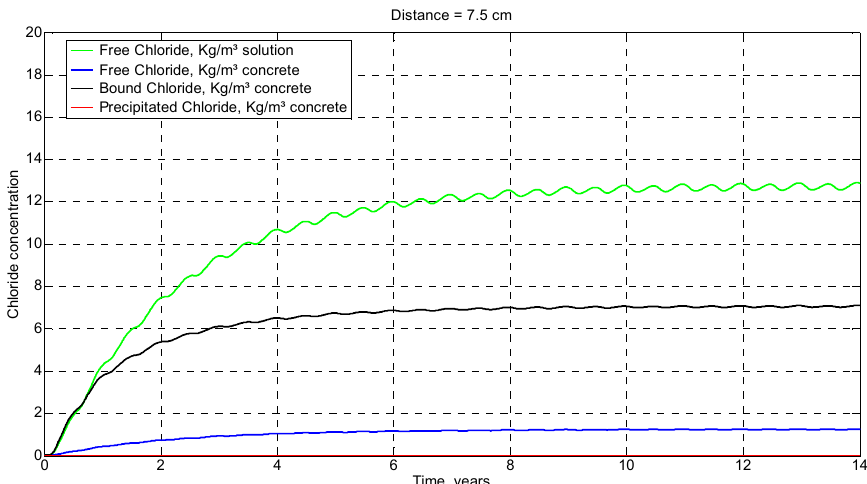
Figure 21. Time dependent concentration of C f,s (free chloride in kg/m 3 solution), C f,c (free chloride in kg/m 3 concrete), C b (bound chloride in kg/m 3 solution) and C p (precipitated chloride in kg/m 3 concrete) at x = 2.5, 5 and 7.5 cm.